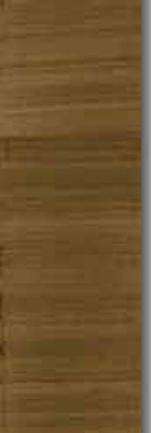
figure 2.11. Using annually layered sediments (called varves) in ocean basins near continental margins, such as the cariaco Basin off of venezuela, past climate and ocean dynamics can be studied in great detail. ocean drilling results from the cariaco Basin include clear indications of changes in rainfall, such as the strength and frequency of el niño events, that had an impact on regional habitability and the mayan civilization (e.g., haug et al.,